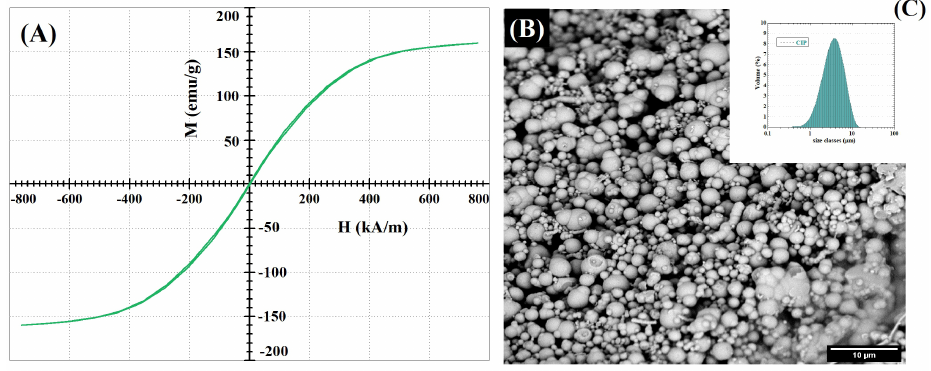
Figure 10. Characterization of CIPs used in MR hydrogels: ( A ) Magnetization hysteresis curve of CIPs; ( B ) SEM micrograph of CIPs; ( C ) CIP size